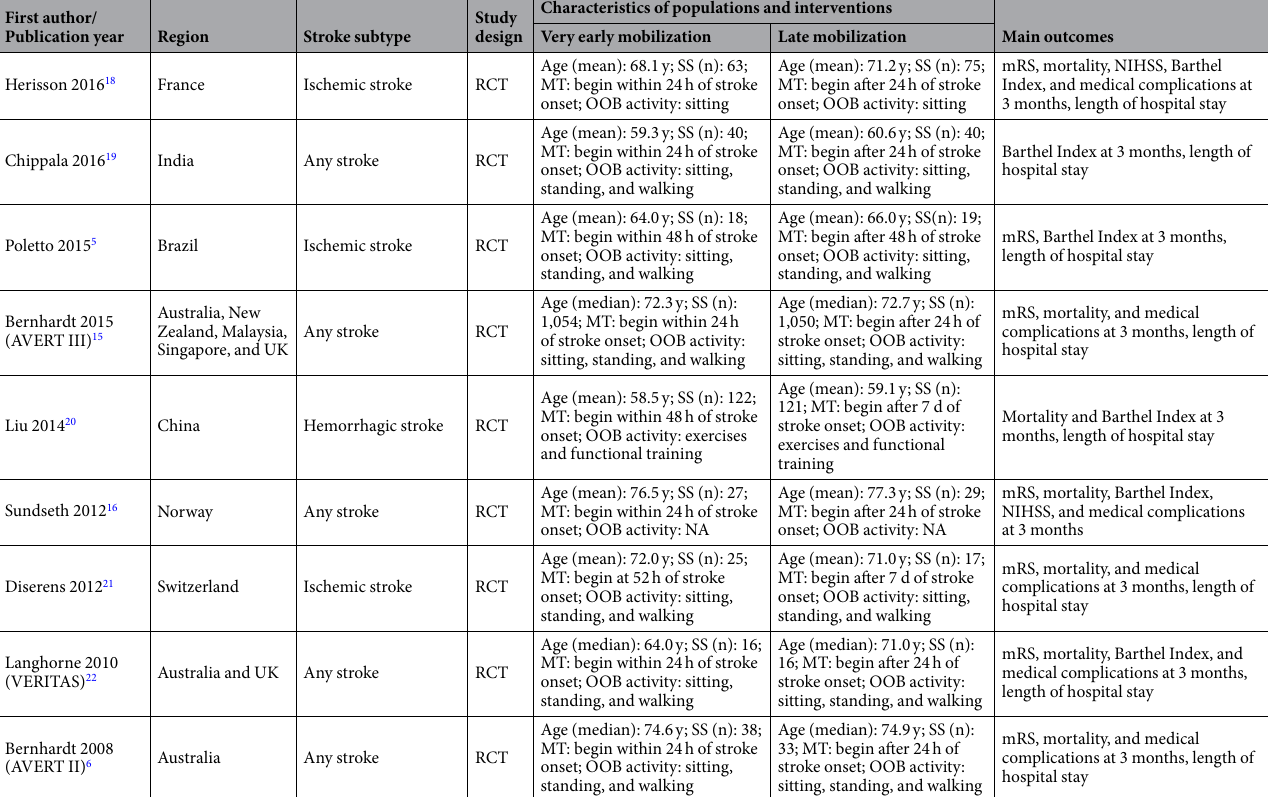
Table 1. Characteristics of the included studies. Abbreviations: RCT, randomized controlled trial; SS, sample size; MT, mobilization time; OOB, out of bed; NA, not available; mRS, modified Rankin